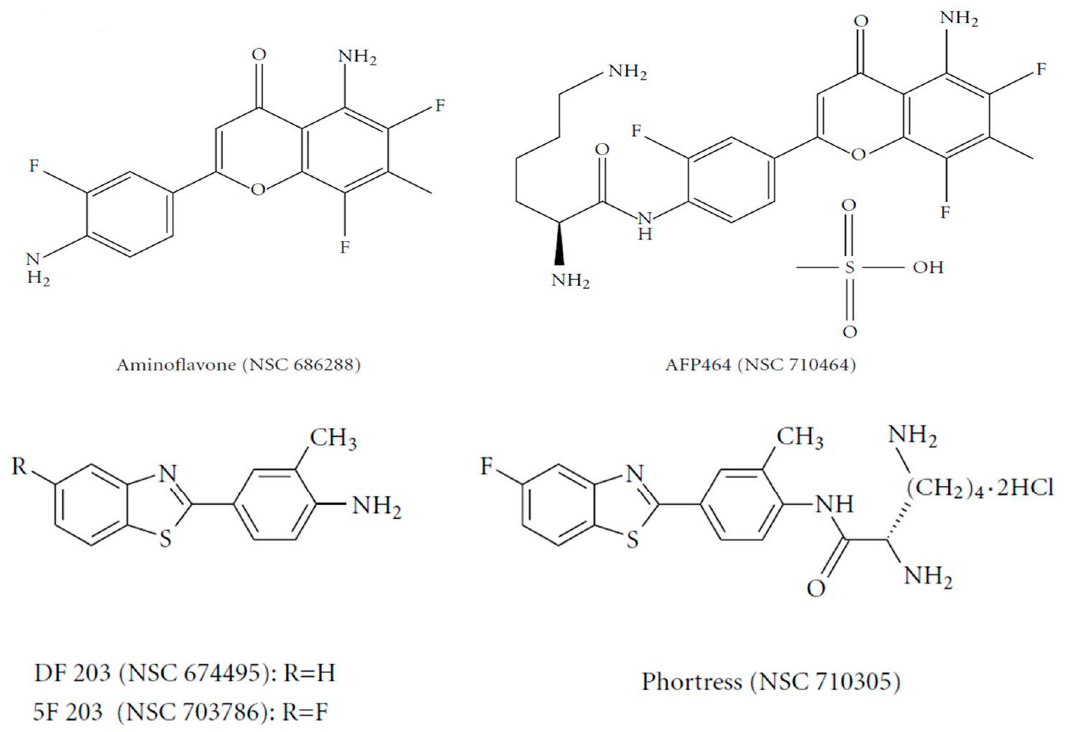
Figure 2. Chemical structures of aminoflavones and benzothiazoles.